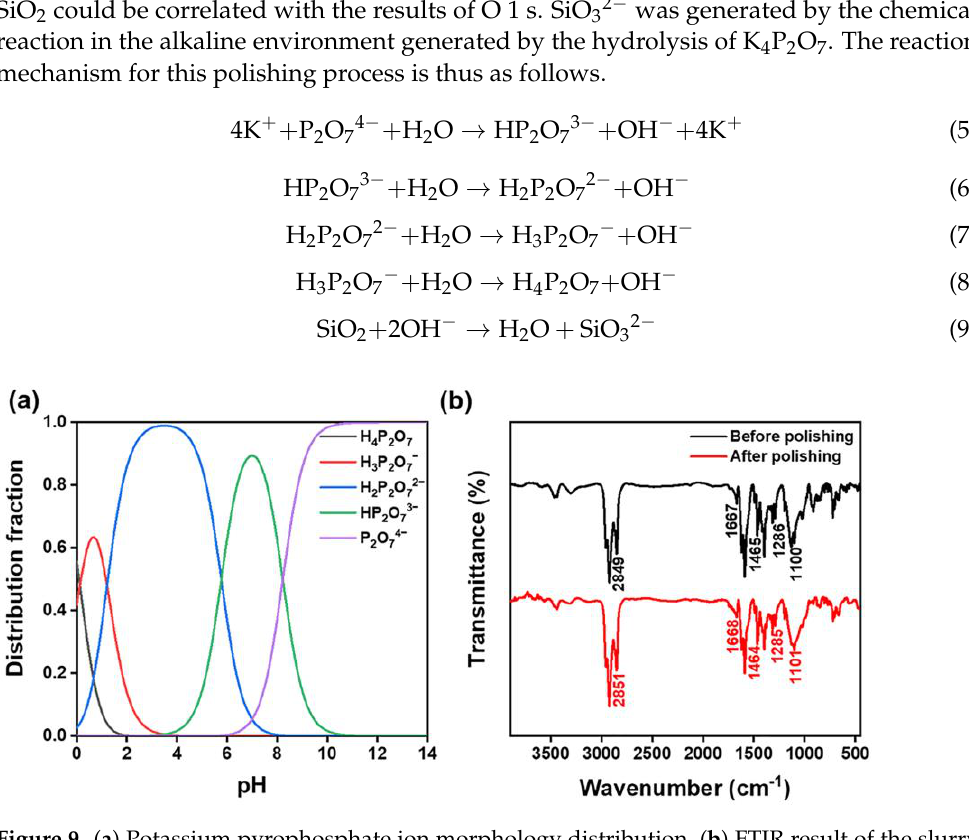
Figure 10. Dispersant chelation reaction with softened layer.